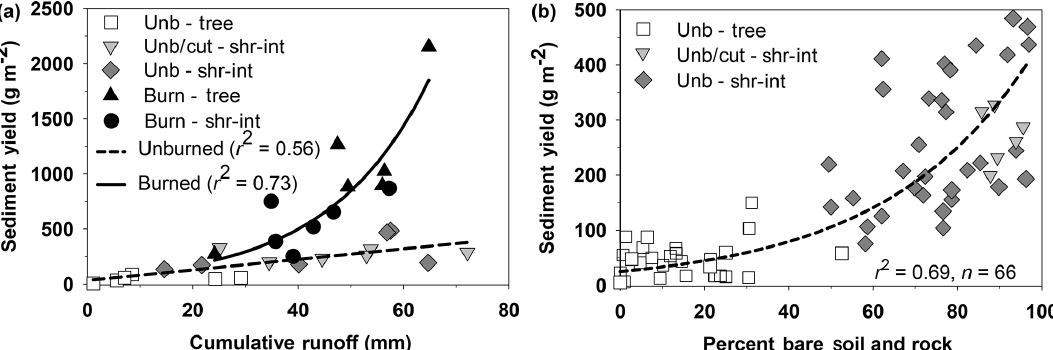
Figure 4. Example relationships/correlations in large rainfall plot cumulative runoff and sediment yield for unburned (untreated (unb) and cut (cut) treatments) and burned (burn) tree (tree) and intercanopy (shrub–interspace, shr-int) plots at the Castlehead site (a) and bare ground (bare soil plus rock cover) and sediment yield for unburned (unb) and cut treatment (cut) tree and intercanopy plots across all study sites (Castlehead, Marking Corral, and Onaqui) (b) . The relationship in runoff and sediment yield (a) demonstrates the initial (1 year) impact of burning on sediment availability and elevated sediment delivery (for tree coppices in this study) as commonly reported in fire studies (Pierson and Williams, 2016). The relationship in bare ground and sediment yield (b) shows the typical increase in sediment yield where bare ground exceeds 50%–60% as commonly reported for rangelands (Pierson et al., 2008, 2009; Williams et al., 2014b). Figures modified from Pierson et al. (2013) and Williams et al.